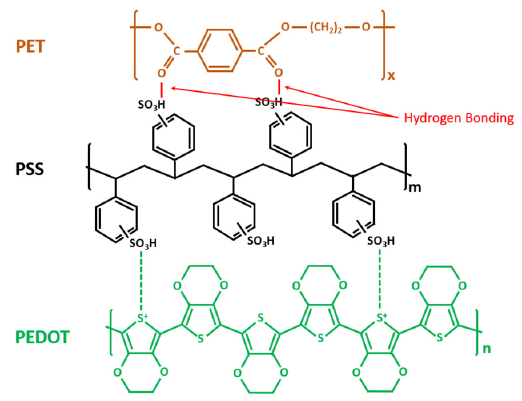
Figure 3. Chemical structures of poly(3,4-ethylenedioxythiophene):poly(styrenesulfonate) (PEDOT:PSS), polyethylenterephthalat (PET) and their chemical bonds.